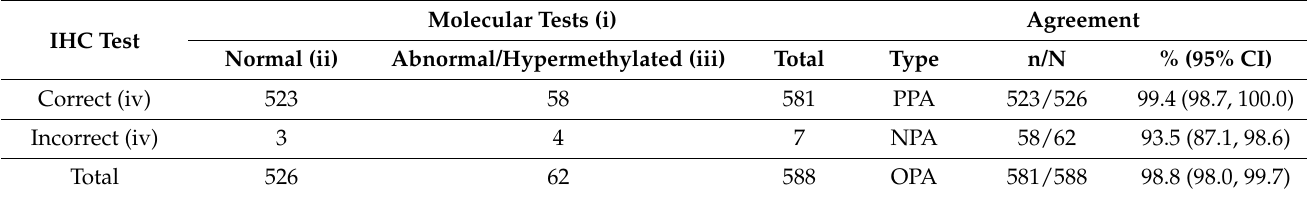
Table 1. Primary pooled analysis for MMR markers plus BRAF